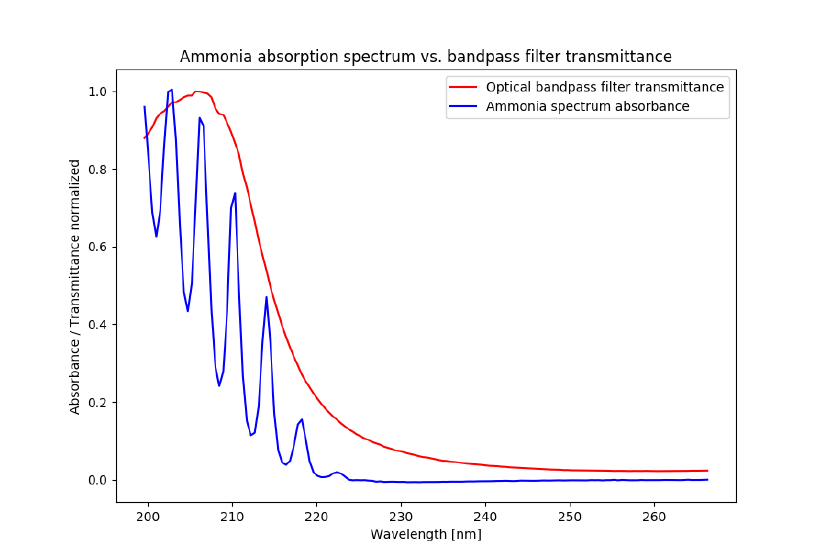
Figure 2. Nondispersive absorption spectroscopy measurement setup; ( a ) measurement setup of a single optical beam; ( b ) picture of the detector board containing the optimized transimpedance amplifier and the photodiode.